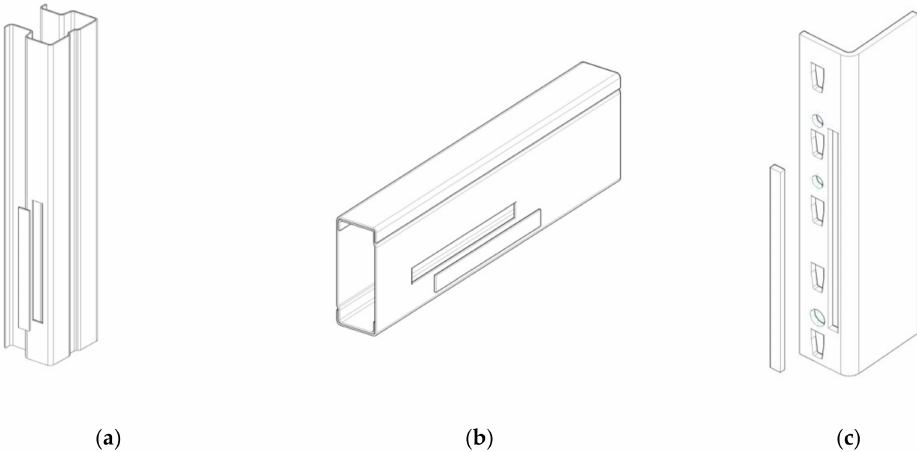
Figure 5. Locations from where we have cut the samples to make tensile tests: ( a ) from upright, ( b ) from beam, and ( c ) from beam end